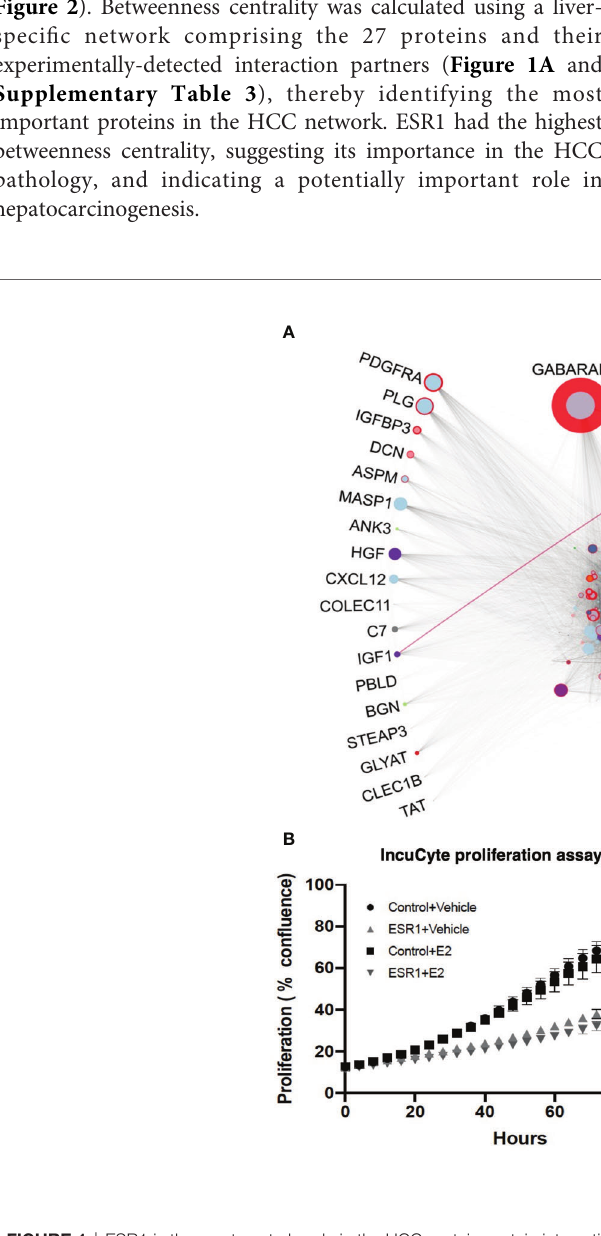
FIGURE 1 | ESR1 is the most central node in the HCC protein-protein interaction network, and its overexpression affects HepG2 cells proliferation and viability re fl ecting its importance in HCC pathogenesis. (A) HCC protein-protein interaction network. The diameter of the red circle is proportional to the centrality of the protein. The size of the circles is proportional to the degree of the protein. Gene Ontology molecular function of the proteins is highlighted as node color, shown in the legend in the bottom-right corner. Red edges highlight direct interaction of ESR1 with other most central proteins. The proteins listed on the left are those dysregulated most commonly in the 19 datasets and with consistent modulation. Despite being the most commonly dysregulated, none of these are central to the HCC PPI network. (B) Results from the IncuCyte proliferation assay. ESR1-overexpressing cells proliferated signi fi cantly less than the control cells. Images were acquired every four hours for up to 90 hours. Mean with SD values from N=3 independent experiments are represented in the graph. ***p < 0.001, One-way ANOVA, Tukey correction for multiple comparisons. (C) Viability assay with Alamar Blue performed in n=3 independent experiments at 72 hours after transfection shows signi fi cant decrease of cell viability in cells transfected with ESR1 compared to the control vector Mean with SD values from N=3 independent experiments are represented in the graph. **p < 0.01, One-way ANOVA, Tukey correction for multiple comparisons. SD, standard